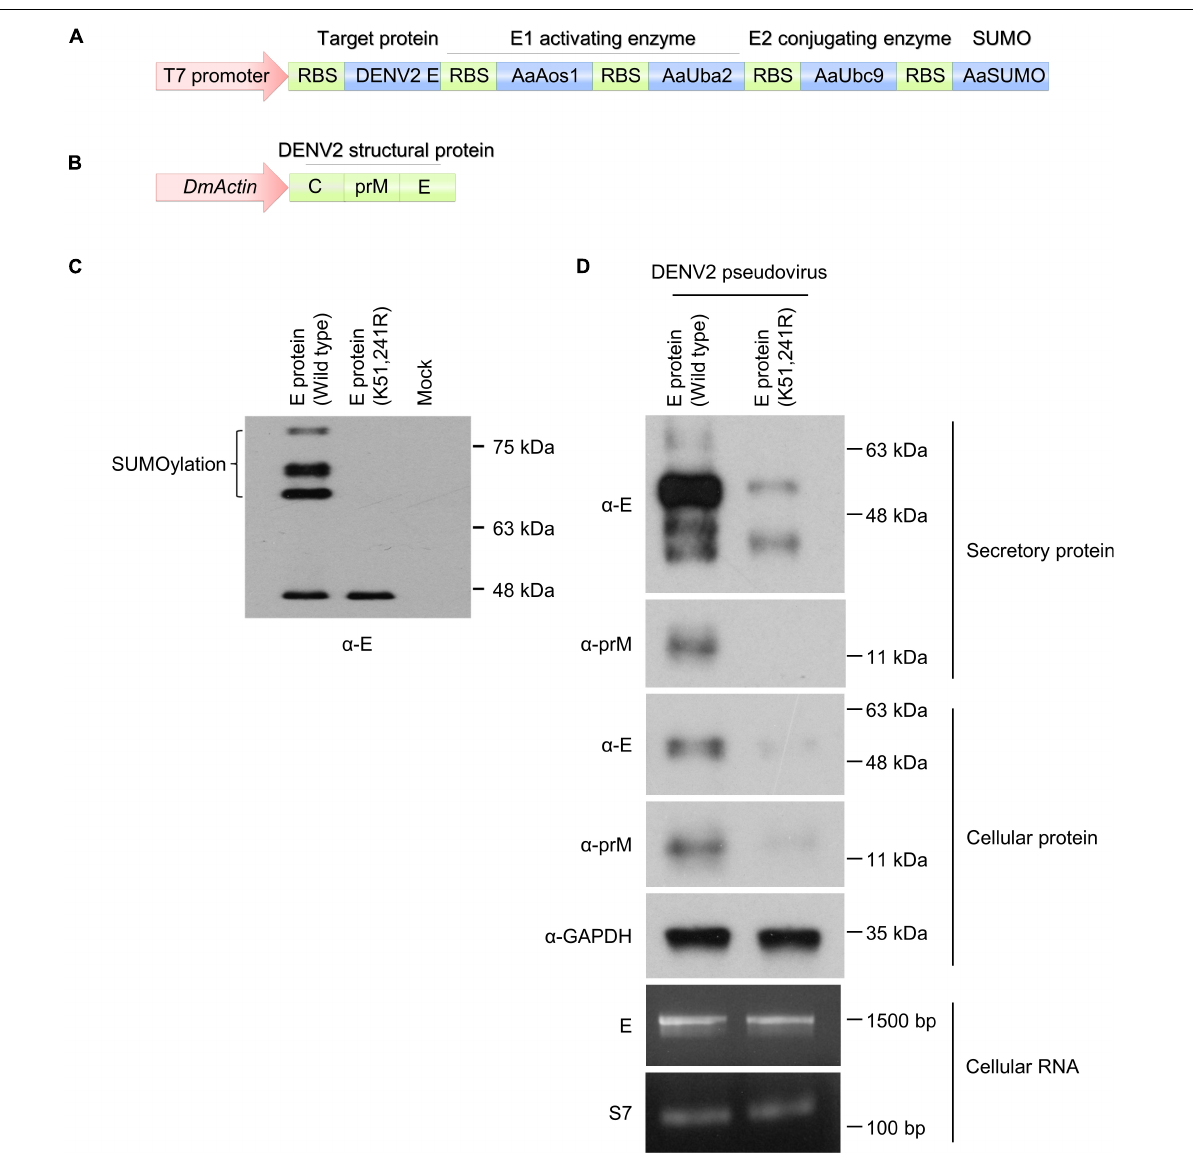
FIGURE 5 | DENV2 envelope protein SUMOylation is essential for viral particle production in mosquito cells. (A) A plasmid encoding the linear fusion of mosquito SUMO-E1 (AaAos1 and AaUba2), SUMO-E2 (AaUbc9), SUMO protein, and target protein (wild type or K51/241R mutant of DENV2E). (B) A plasmid encoding the linear fusion of DENV2 prM and E proteins linked to an actin 5C promoter. (C) The plasmid depicted in A was transformed into E. coli BL21 (DE3) and protein expression was induced with 1 mM IPTG at 25 ◦ C. Four hours post protein transcription induction, the bacterial lysate was analyzed by western blot using anti-E antibody. (D) The plasmid described in B was transfected into CCL-125 cells. Four days post transfection the secretory virus-like particles, cellular protein lysate, and cellular RNA were collected and analyzed by western blot and